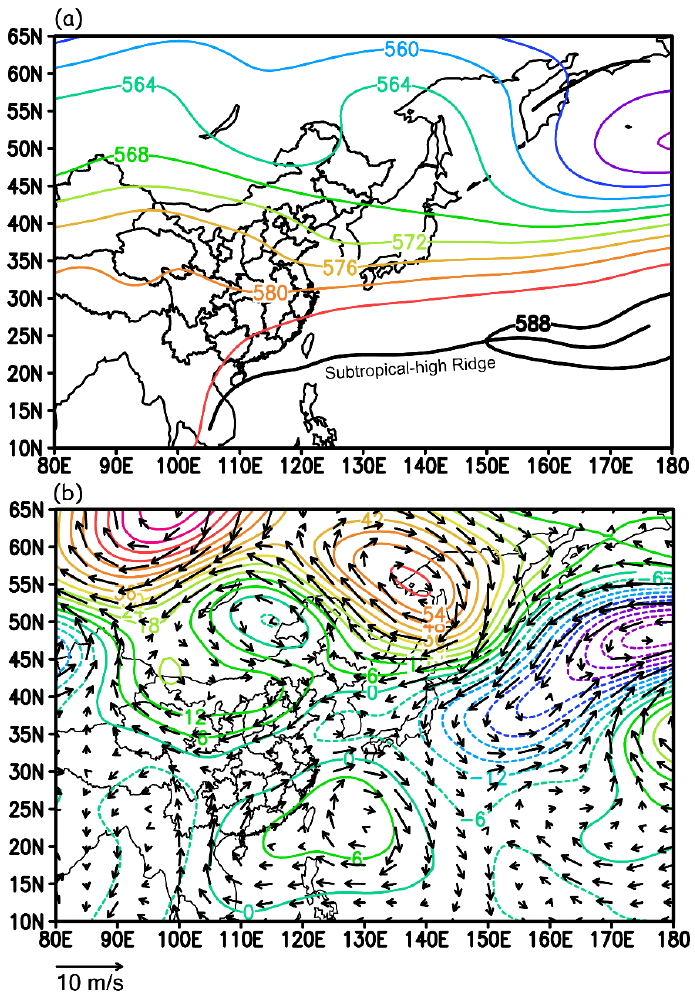
Figure 4. ( a ) The 500 hPa geopotential height in summer 1954; ( b ) the geopotential height (contours) and wind anomalies (vectors) in summer 1954. The data used in the figures include geopotential height data, meridional wind data, and zonal wind data in NCEP/NCAR reanalysis dataset [27]. Between May and July, the WPSH stably moved between 20N and 25N, causing wet and warm air to move toward the Yangtze River valley and precipitation to be maintained around the mid- and low-Yangtze areas along the